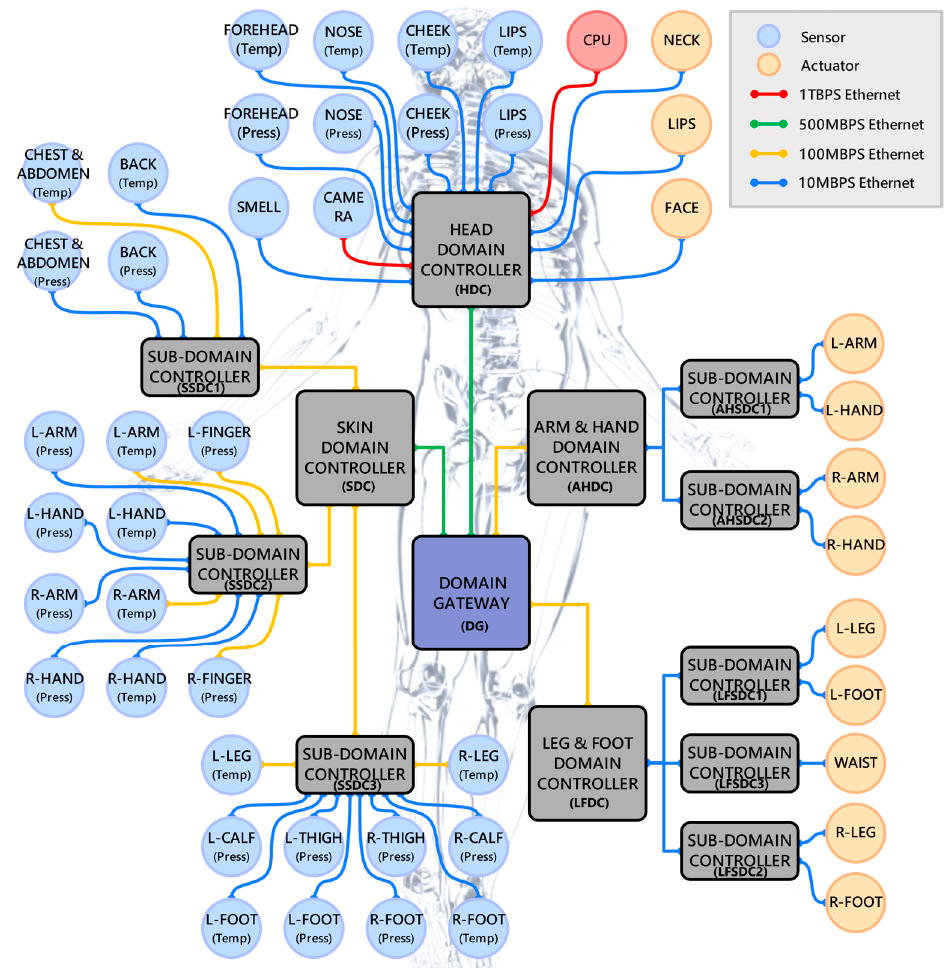
Figure 3. Body structure of domain IRN architecture. The network is divided into Head Domain, Arm and Hand Domain, Leg and Foot Domain, and Skin Domain.